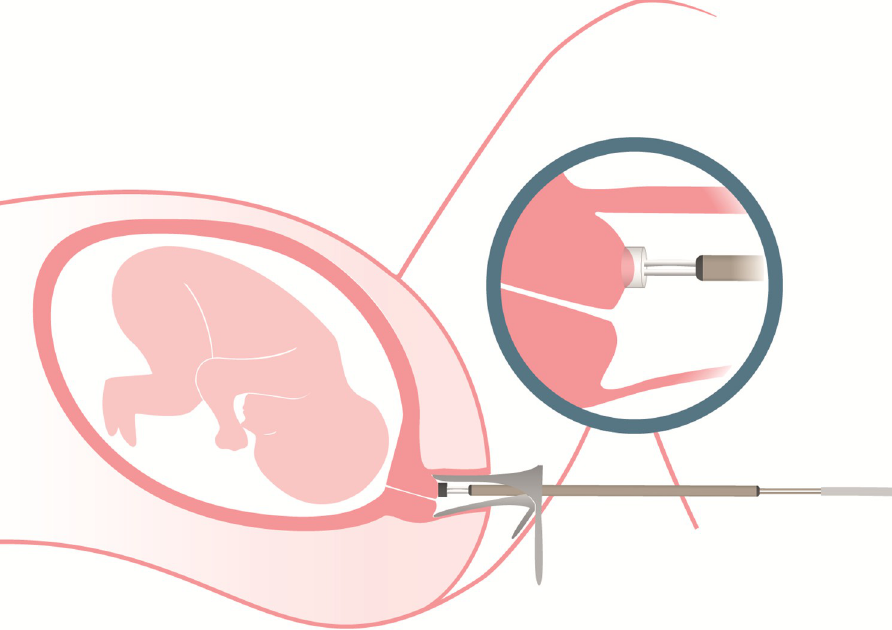
Fig 2. General overview of the method and application. The probe is manually placed on the cervix during a routine gynaecological evaluation, with the aid of a speculum. Adapted from [20].